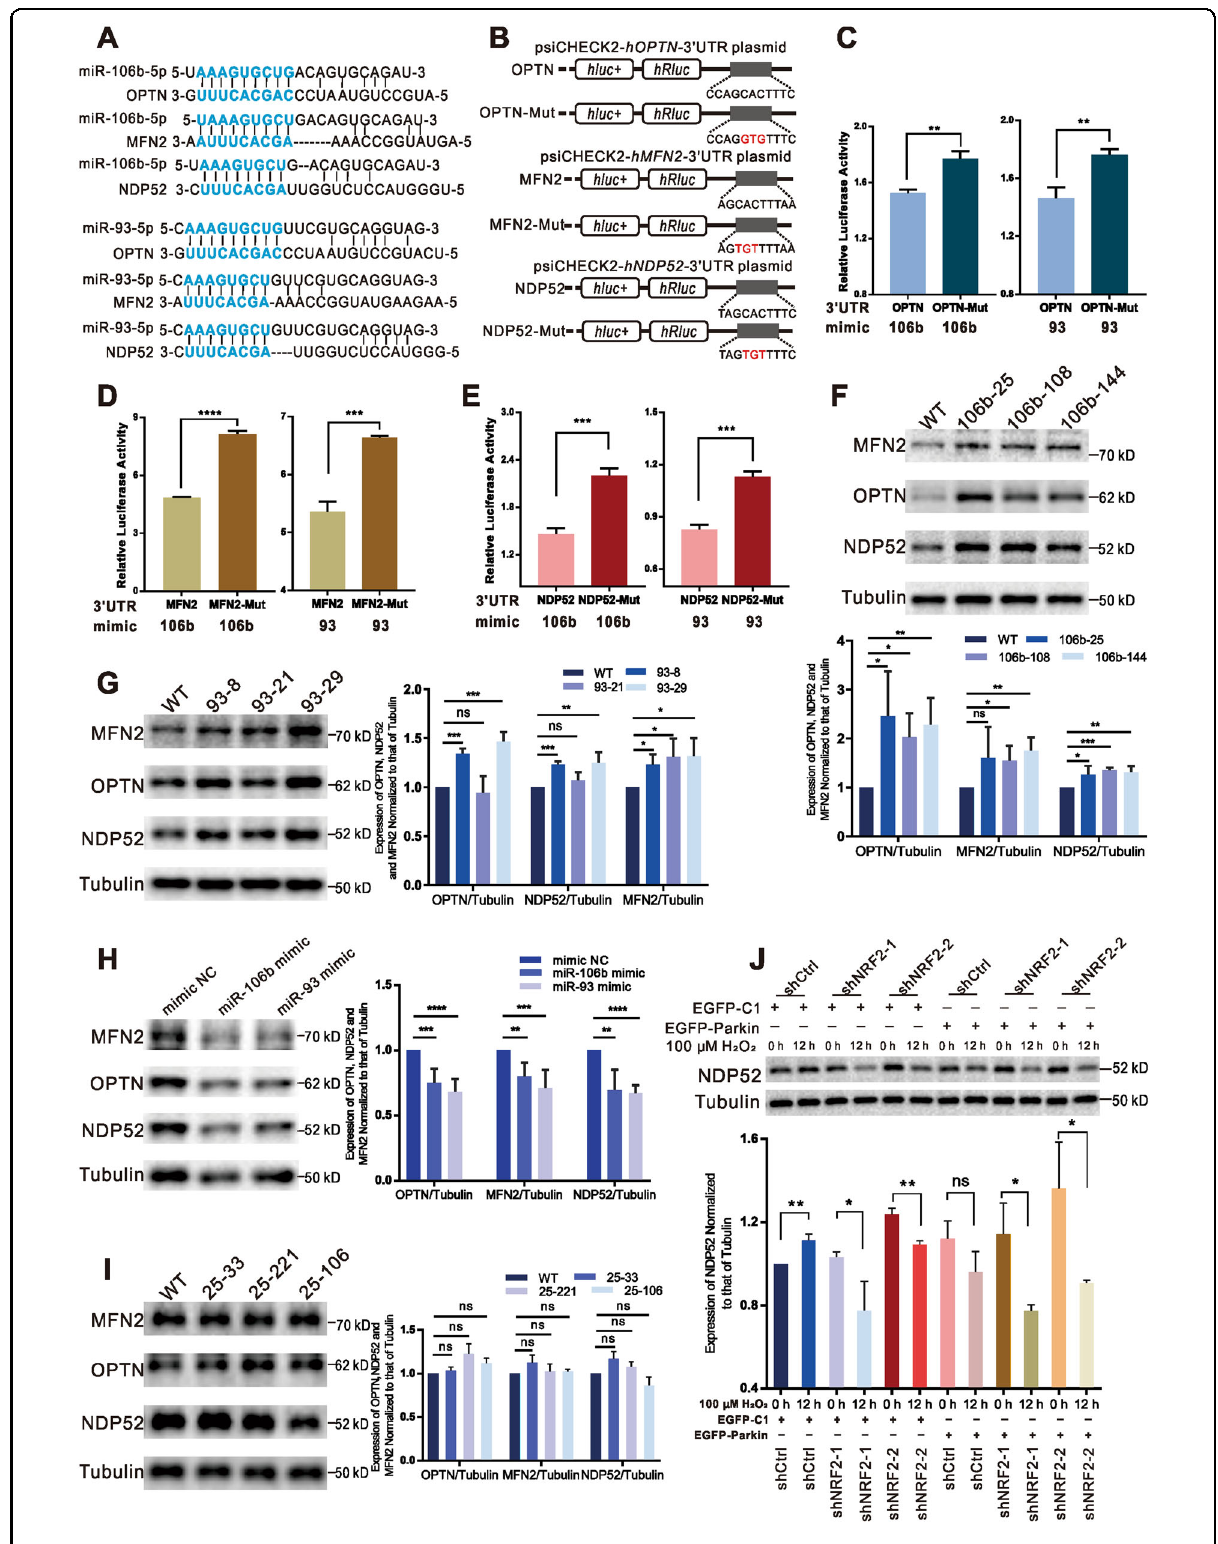
Fig. 3 (See legend on next